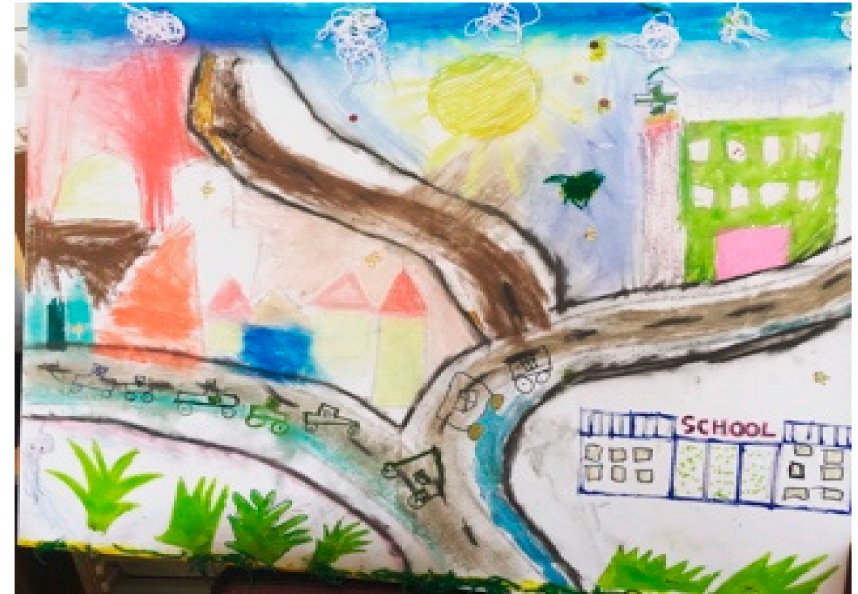
Figure 3. Future city, example two from a northern English Primary School 2018. This image features a school and a hospital (the green building) a mosque, a church and a number of houses. RMIT University Human Ethics Clearance Number